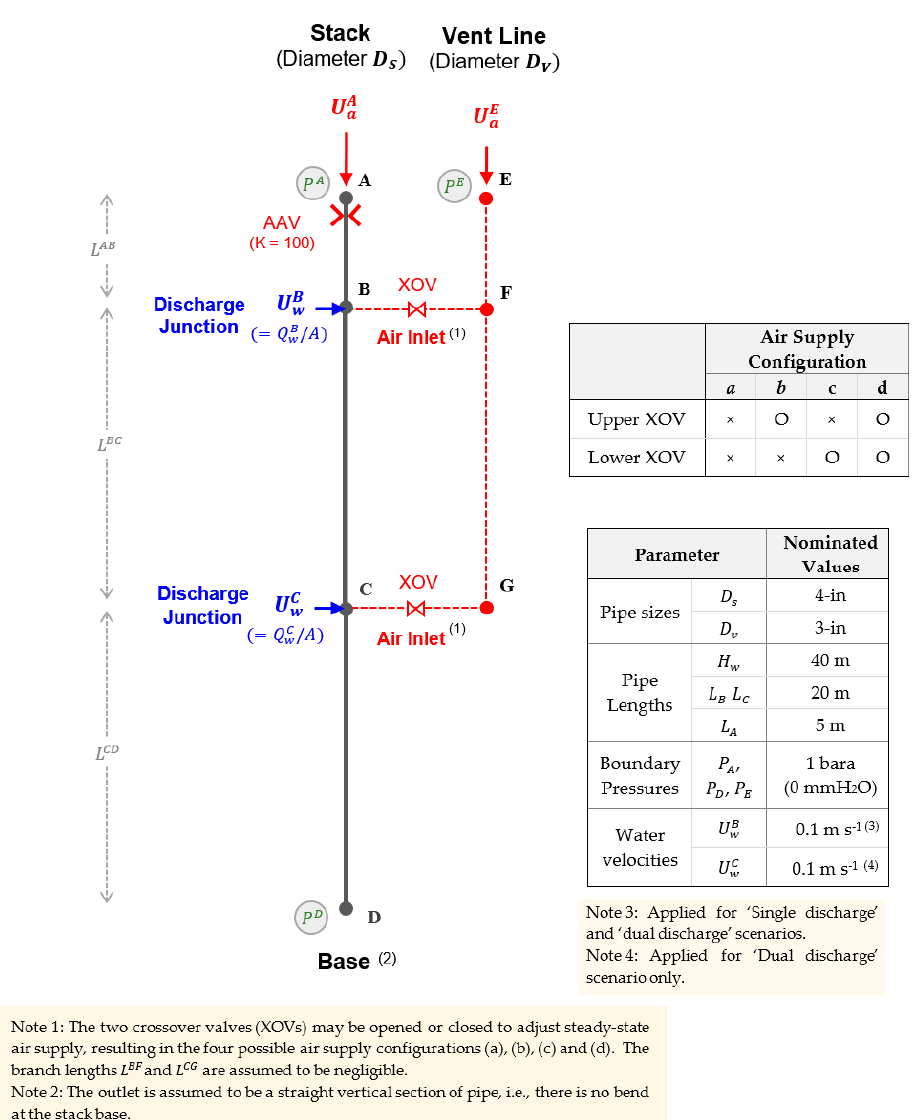
Figure 11. Drainage network schematic diagram. Nominated parameter values used to perform case studies described in Section 7 are summarized in the table.